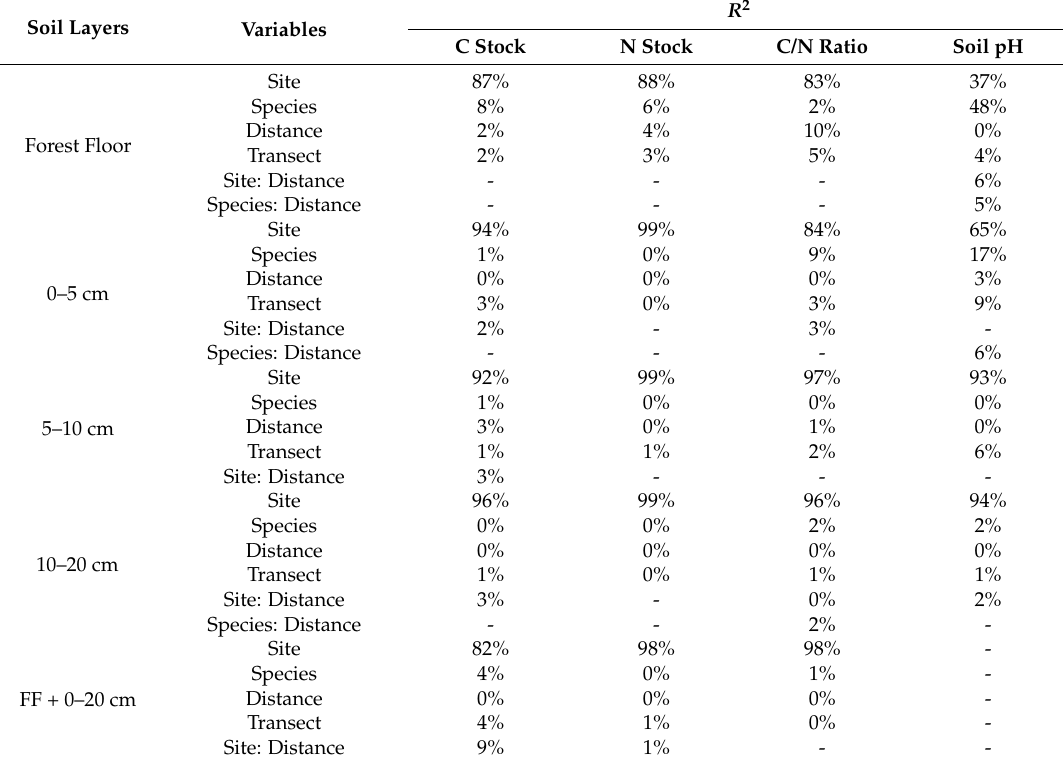
Table 5. Proportion of variation in soil properties explained by each explanatory variable by each soil layer. See Table S13 for the R 2 values of the